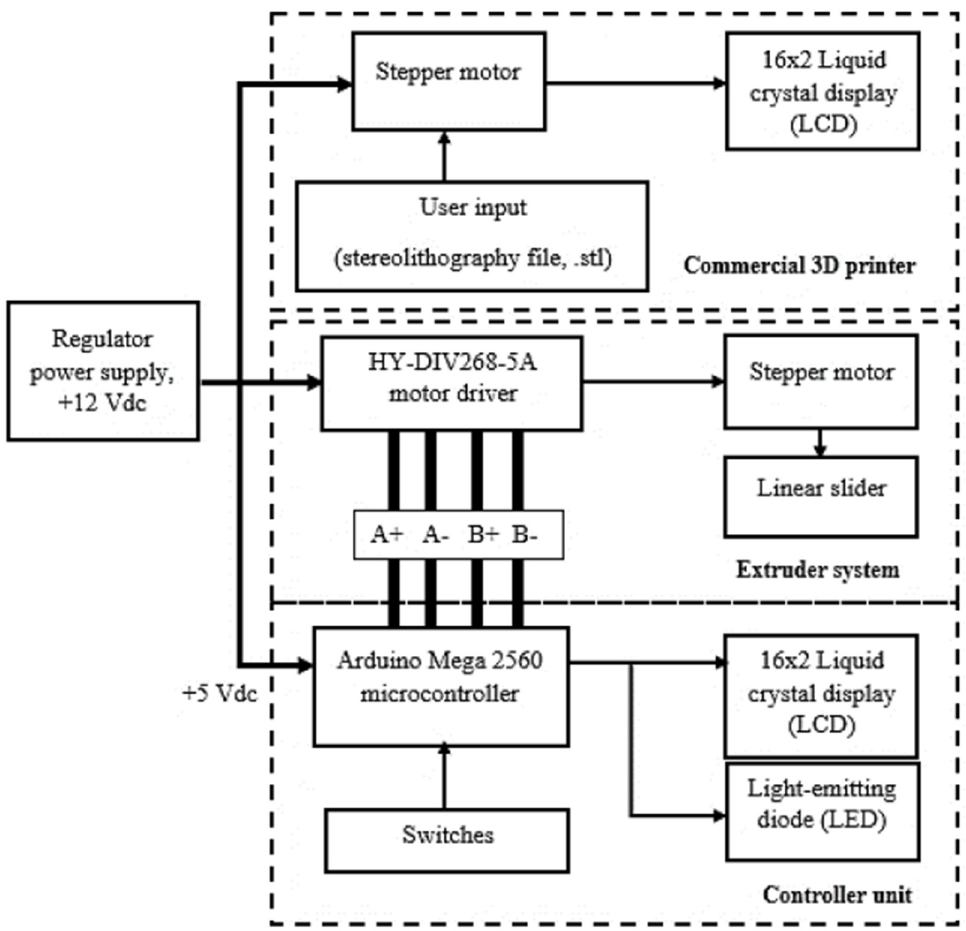
Figure A1. The block diagram of the 3D micro-extrusion bioprinting system design.